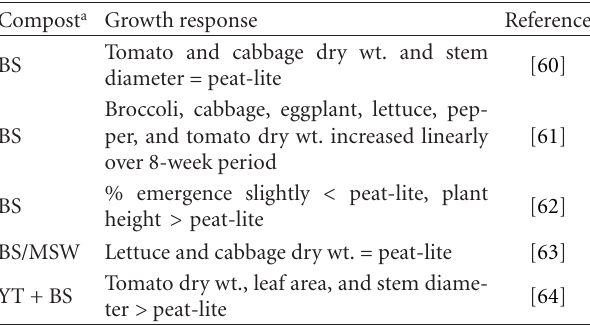
Table 3: Benefits of biosolids composts used in growing media for vegetable transplants (modified from